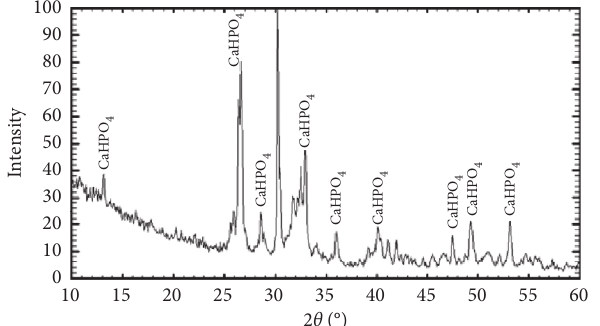
Figure 9: X-ray diffraction diagram of the solid phase formed during the precipitation of DCPA ( M 4).